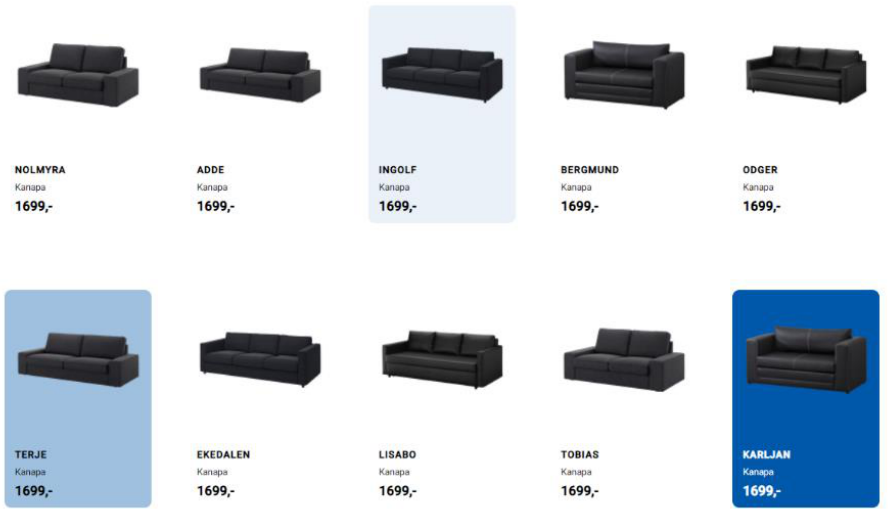
Figure 4. Sample products with different intensities of colored background. Source: own elabora- tion.